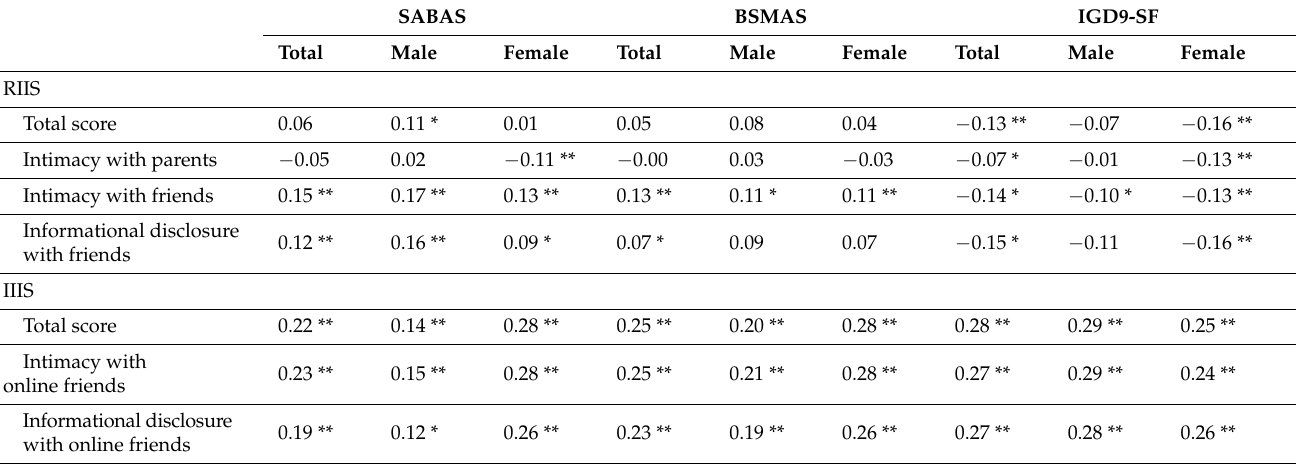
Table 2. Correlation coefficients among Smartphone Application-Based Addiction Scale (SABAS), Bergen Social media Addiction Scale (BSMAS), Internet Gaming Disorder Scale (IGD9-SF), and Real Interpersonal Interaction Scale (RIIS)/Internet Interpersonal Interaction Scale (IIIS), including total score and subscales. SABAS BSMAS IGD9-SF Total Male Female Total Male Female Total Male